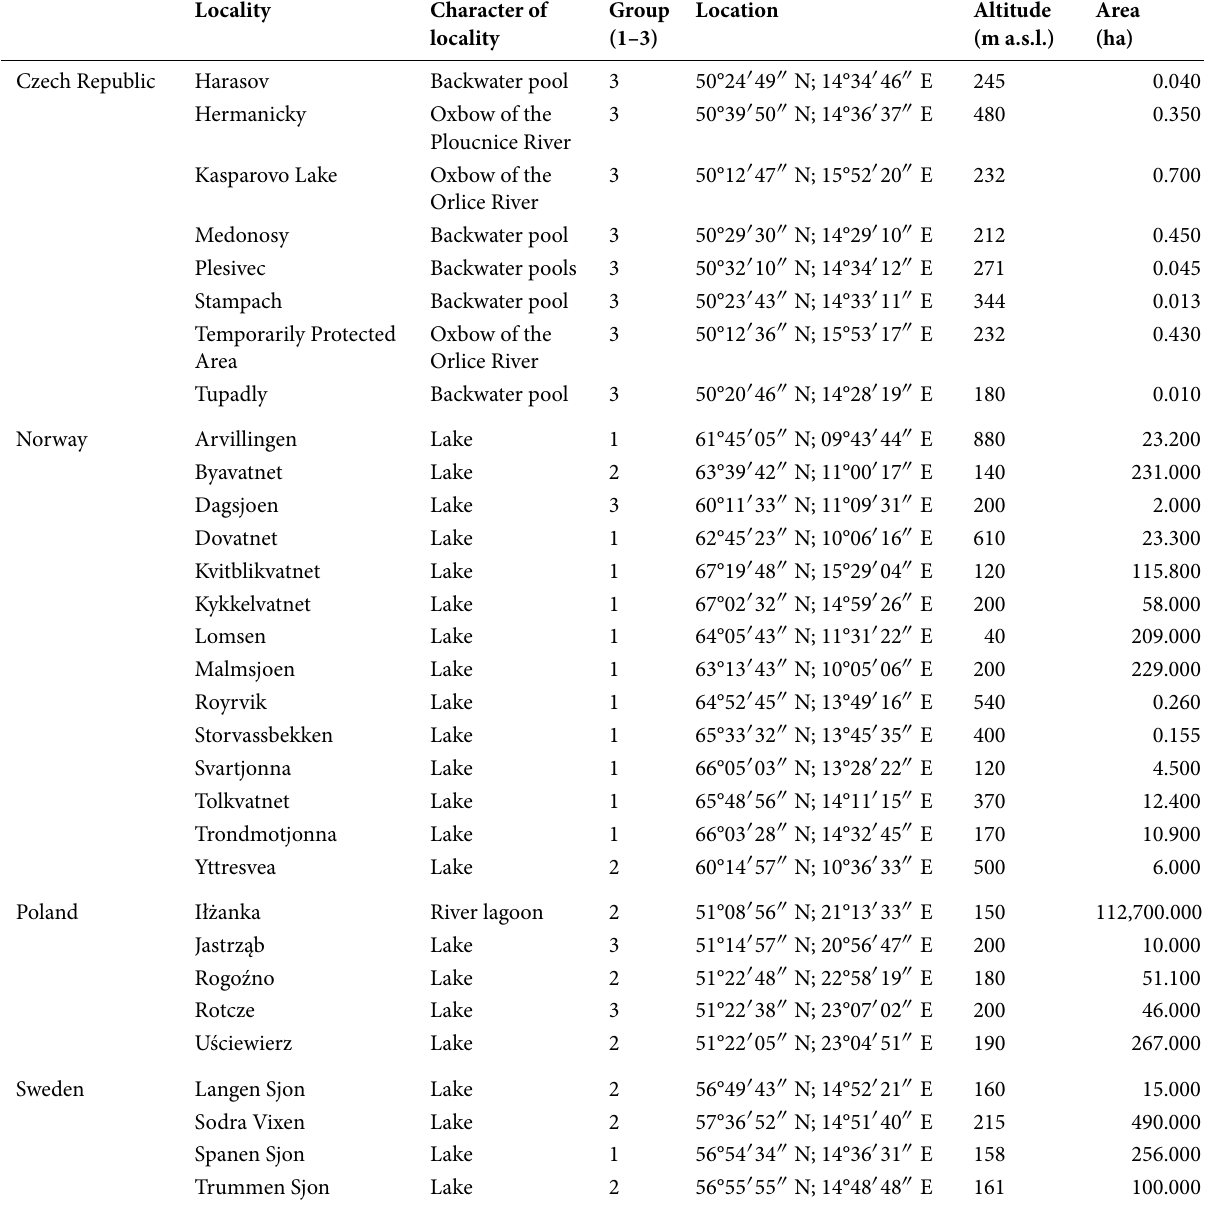
Table 3 Characteristics of the studied localities (Groups 1–3: differentiation of localities according to trophy and occurrence of vascular